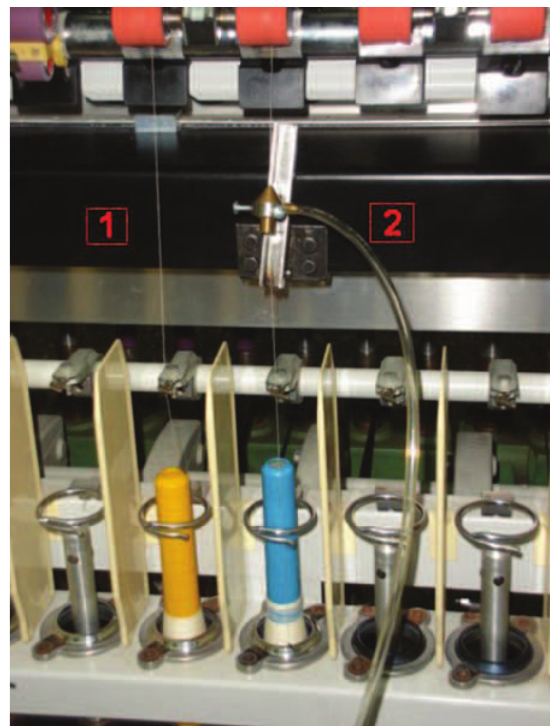
Figure 1 Conventional ring (1) and Jetring (2) spun yarn produc- tion on Rieter G10 ring spinning